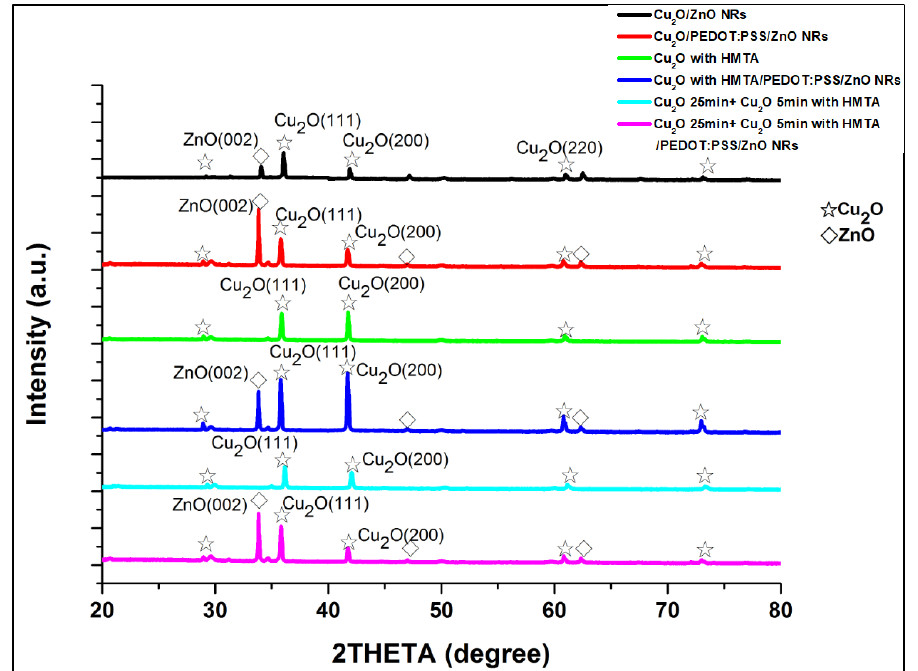
Figure 4. XRD patterns of samples based on Cu 2 O / ZnO and Cu 2 O / PEDOT:PSS / ZnO heterostructure. With the help of HMTA and PEDOT:PSS, the signal in the preferred direction, (111) of Cu 2 O and (002) of ZnO, becomes stronger.